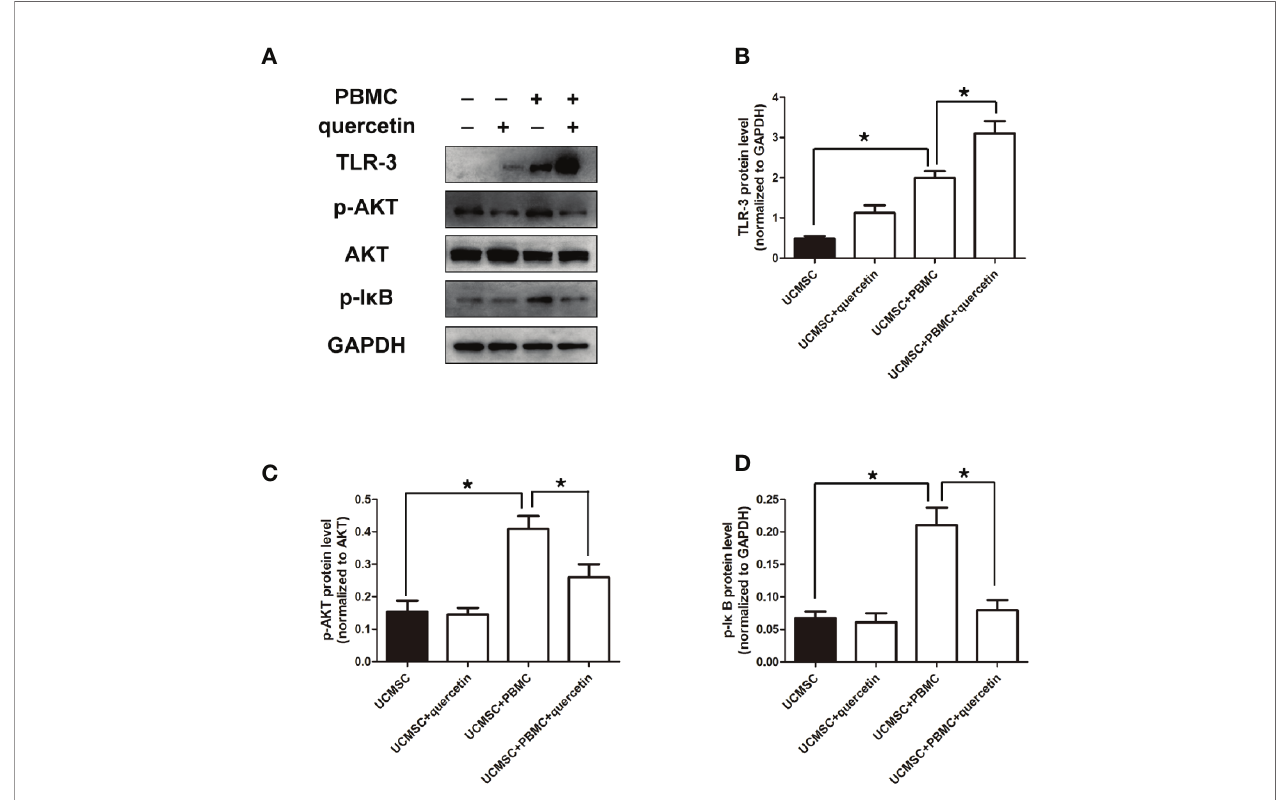
FIGURE 4 | Changes in signaling pathways in UCMSCs. UCMSCs were cocultured with TNF- a /IFN- g -activated PBMCs (1:1 ratio) in the presence or absence of quercetin for 3 days. (A) Expression of TLR-3 and AKT/I k B was assessed by Western blotting. Quercetin induced TLR-3 expression and inhibited AKT/I k B expression in UCMSCs. (B – D) The bar graphs show the quanti fi cation of the indicated proteins. Mean ± SEM, n = 3. * P <